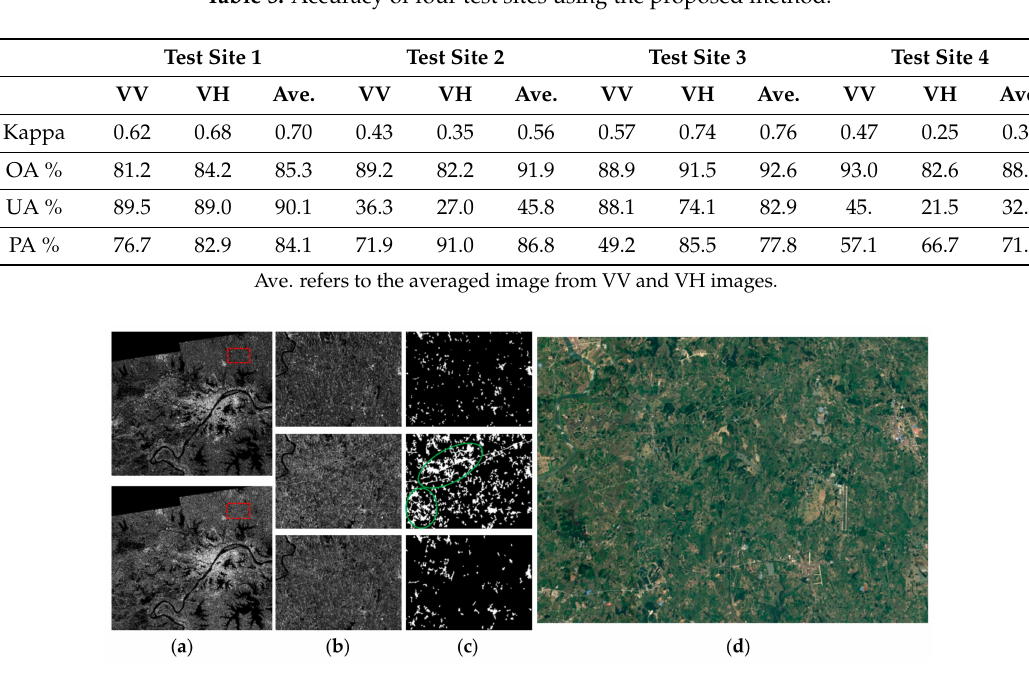
Figure 4. Comparison of BAs extraction results in Wuhan using different image channels. ( a ) VV and VH image of Wuhan from top to bottom; ( b ) from top to bottom are the VV, VH and averaged image of the two channels of the selected ROI in ( a ); ( c ) corresponding BAs extraction result of ( b ); ( d ) the Google Earth optical map of the ROI region. White: built-up areas, Black: other land covers.